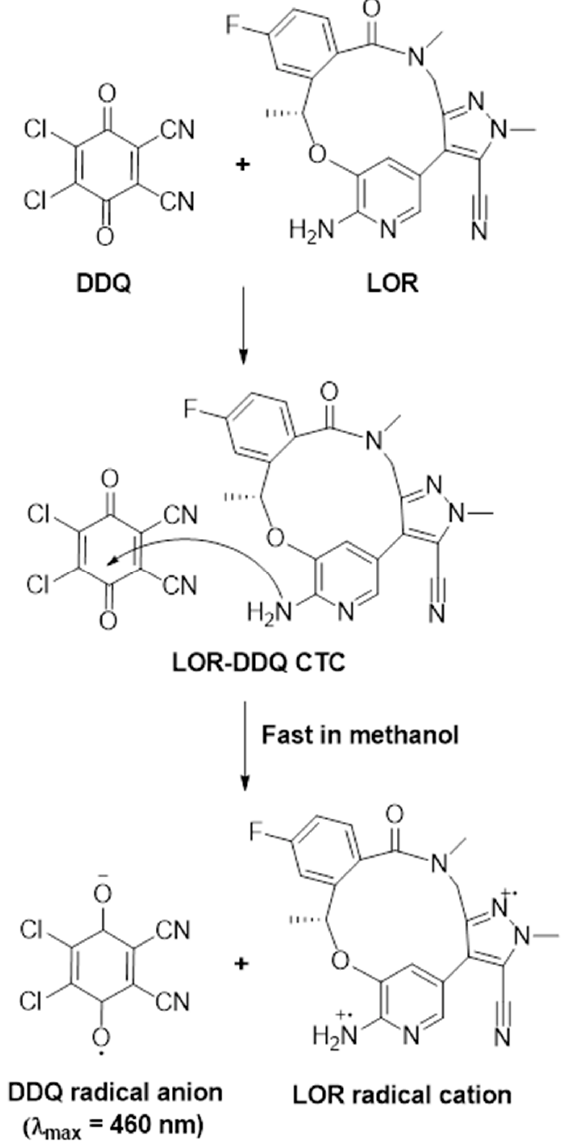
Figure 6. The scheme for the formation of the CTC between LOR and DDQ.